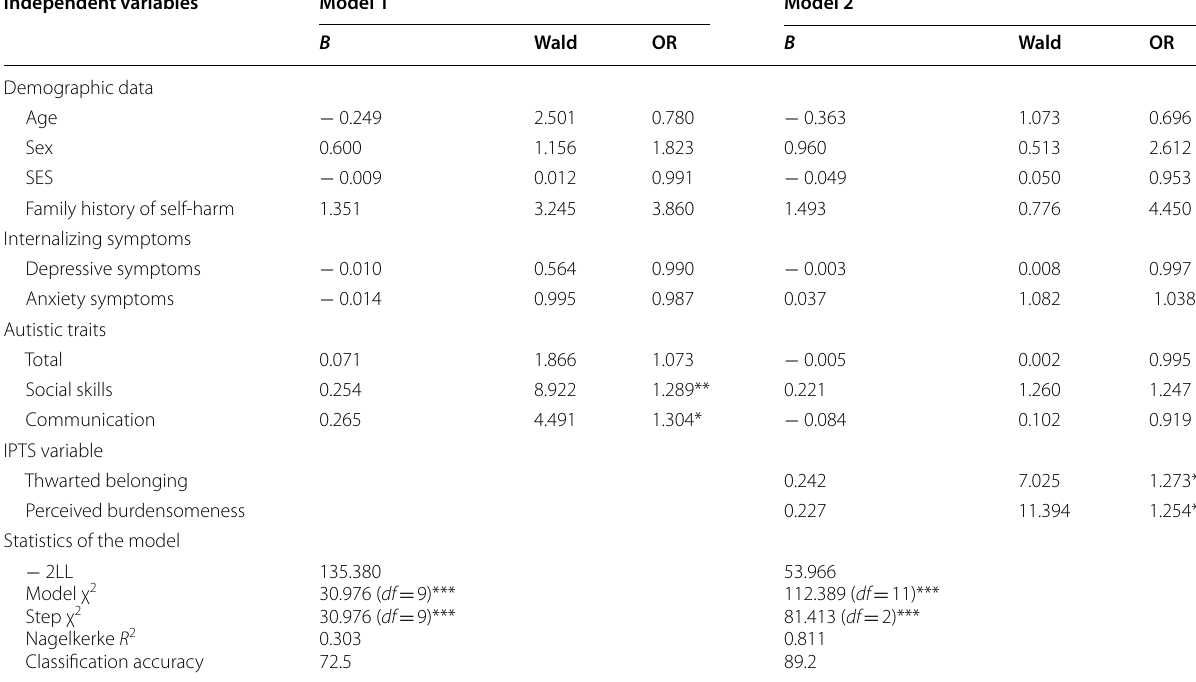
SES socioeconomic status, IPTS Interpersonal Psychological Theory of Suicide * p < 0.05; **p < 0.01; ***p <